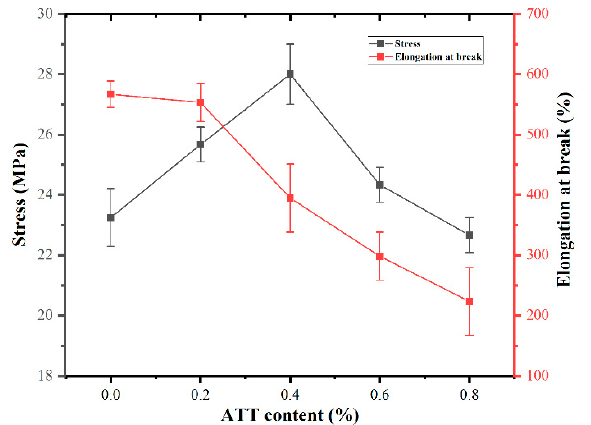
Figure 4. Stress and elongation at break of MPP/ATT nanocomposites containing different amounts of